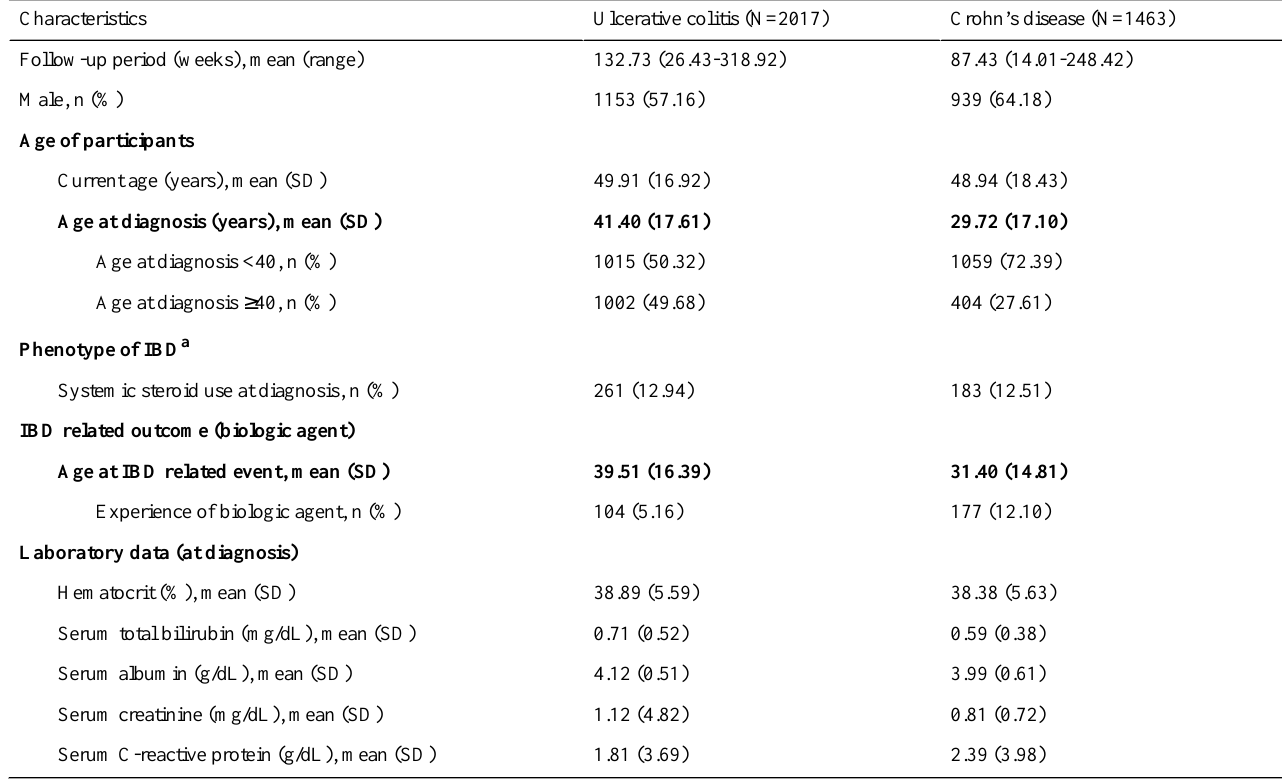
Table 1. Baseline characteristics of all patients with inflammatory bowel disease